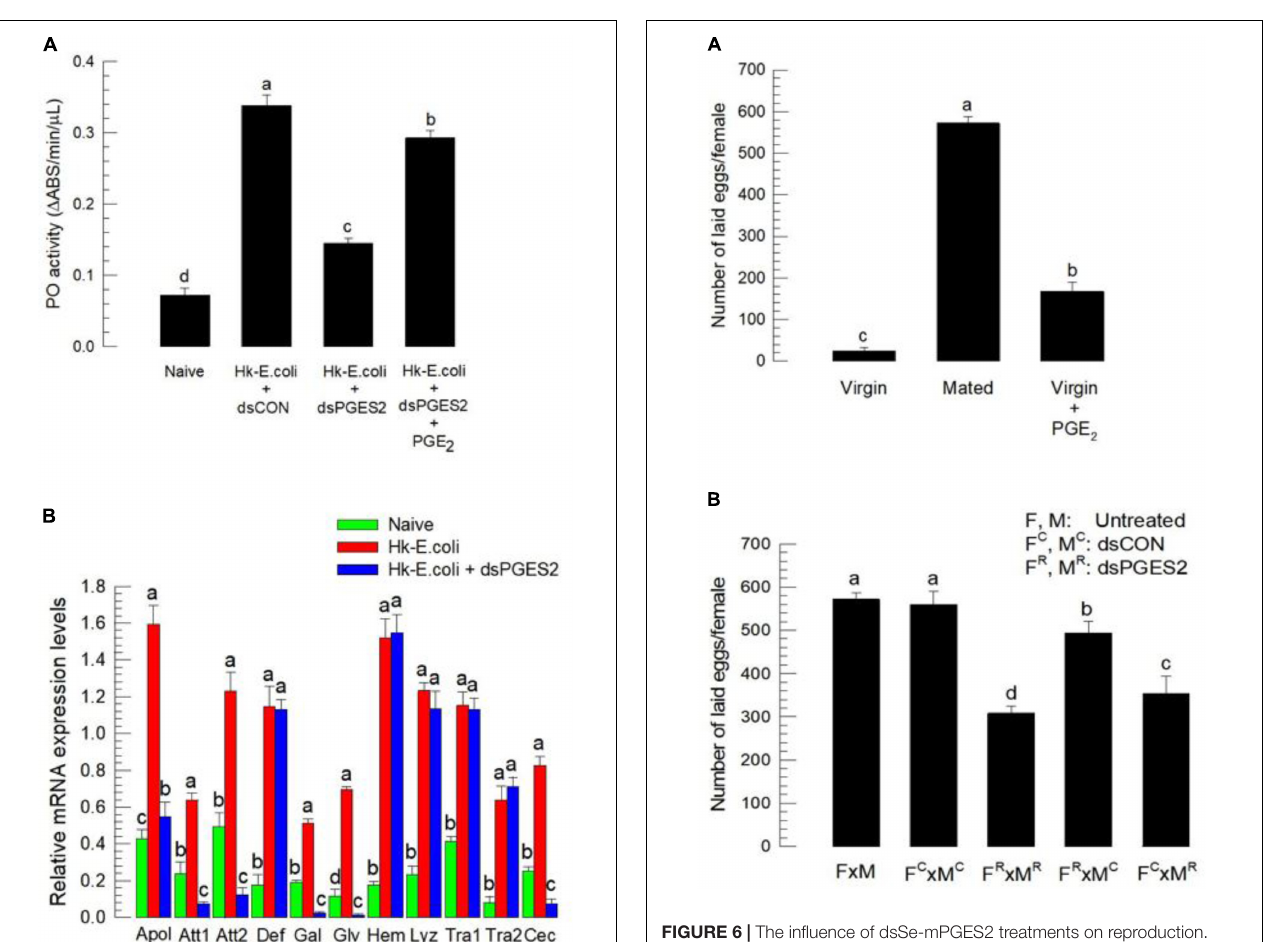
FIGURE 6 | The influence of dsSe-mPGES2 treatments on reproduction. dsRNA was injected as described in Figure 3 into 5 days old male (“M”) or female (“F”) pupae. A viral gene, CpBV302 , was used as a control dsRNA (“dsCON”). (A) Stimulatory effect of PGE 2 on egg-laying behavior. Total number of laid eggs by virgin (without male) or mated (with males in 1:1 sex ratio) was counted for 3 days after adult emergence. PGE 2 (10 µ g per adult) was injected to virgin females at the day of adult emergence. (B) Inhibitory effect of dsSe-mPGES2 treatments on egg-laying behavior. Each treatment consisted of three replicates. Each replicate used 10 females and/or 10 males. Different letters indicate significant differences among means at Type I error = 0.05 (LSD